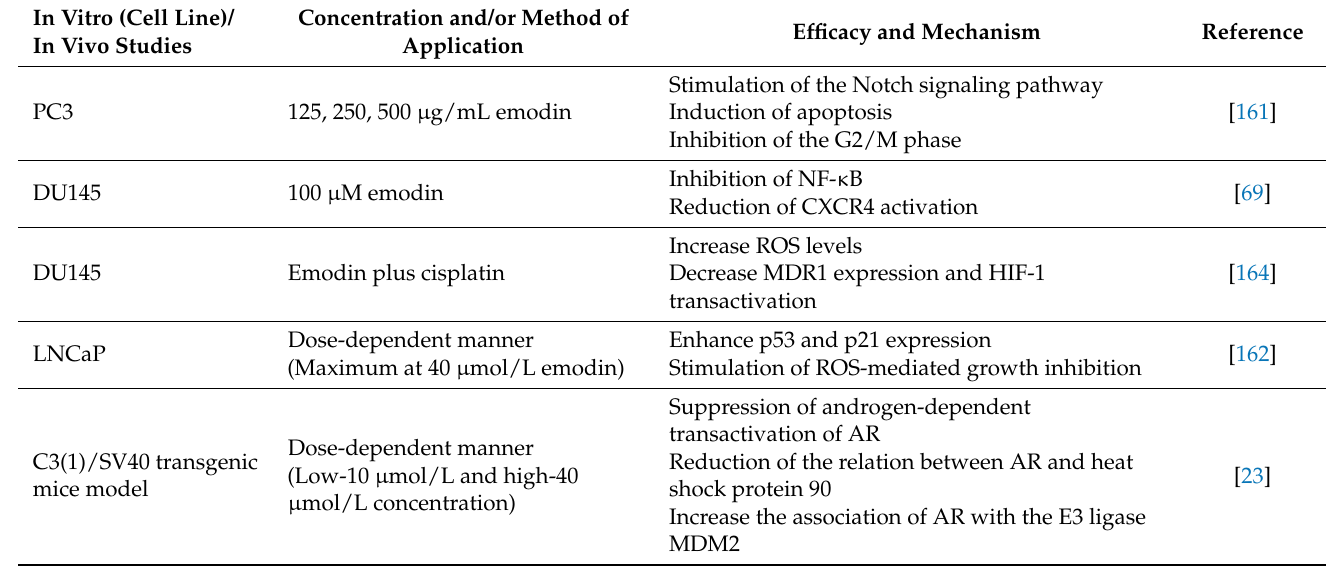
Table 9. Summary of in vitro and in vivo biochemical effects of emodin in prostate cancer cell lines. In Vitro (Cell